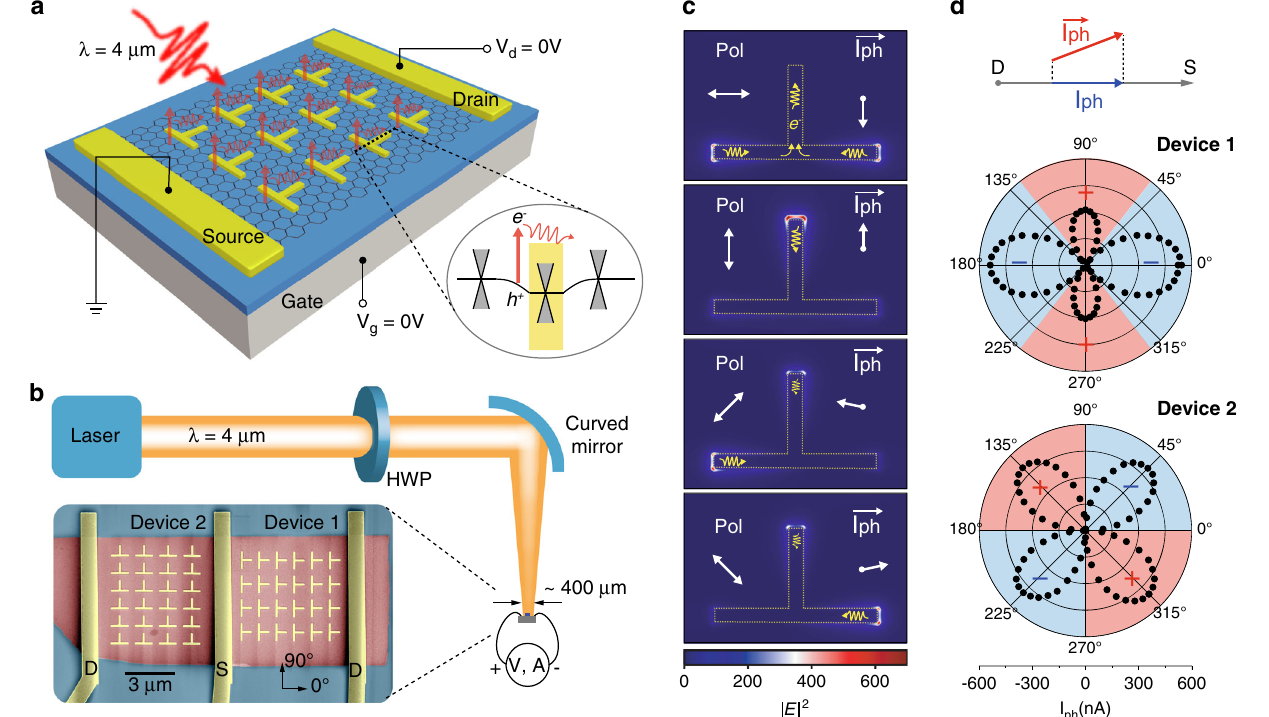
Fig. 1 Design concept and main results of metasurface-mediated graphene photodetectors. a Illustration of the designed metasurface-mediated graphene photodetector, which consists of non-centrosymmetric sub-wavelength metallic nanoantennas as meta-atoms on top of graphene fl akes. Under uniform illumination at 4 µ m wavelength, global directional photocurrents are generated from each meta-atom at zero external bias ( V d = V g = 0 V), mimicking the shift current in the bulk photovoltaic effect (BPVE). Importantly, due to the gapless nature of graphene, the local photoresponse from nanoantennas can ef fi ciently contribute to the external circuit in a nonlocal manner, enabling a cascaded total photocurrent. From bottom to top: Si (gray), SiO 2 (blue), graphene (black honeycomb), Pd/Au for nanoantennas, and electrodes (yellow). Inset illustrates the excitation of electrons at one edge of nanoantennas and the following directional transport. Black line denotes the band diagram of graphene. Yellow area is the graphene region that is covered and doped by metal. b Schematic of the experimental setup with control of the linear polarization state via rotation of half-wave plate (HWP). The focused laser beam has a beam diameter around 400 μ m, which is much larger than the size of our device. The inset shows the scanning electron microscopy (SEM) image of our device in false colors: graphene in dark red, nanoantennas, and electrodes in yellow, substrate in dark blue. c Simulated near- fi eld distribution and predicted vectorial photocurrent in a unit cell at different polarization angles of incident light (Pol). | E | 2 represents the intensity of local electrical fi eld. Yellow wave arrows indicate the fl ow of photocarriers generated at the nanoantenna – graphene interfaces. White arrows illustrate the resultant vectorial photocurrents ( I ph ). d Polar plot of measured I ph , which is the scalar projection of I ph on the orientation of drain – source electrodes. Red and blue areas mark the positive and negative signs of I ph